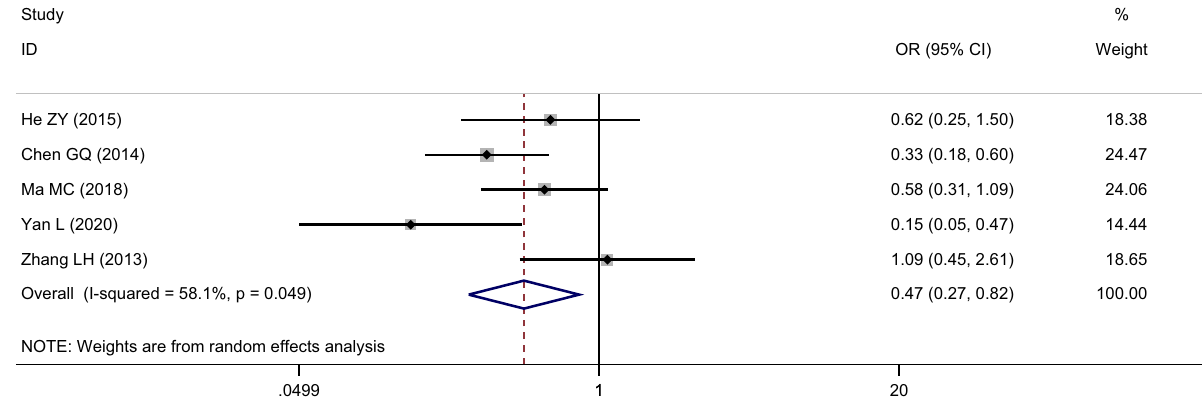
Figure 4: Forest fi gure of relationship between the expression of SIRT1 and in fi ltration of